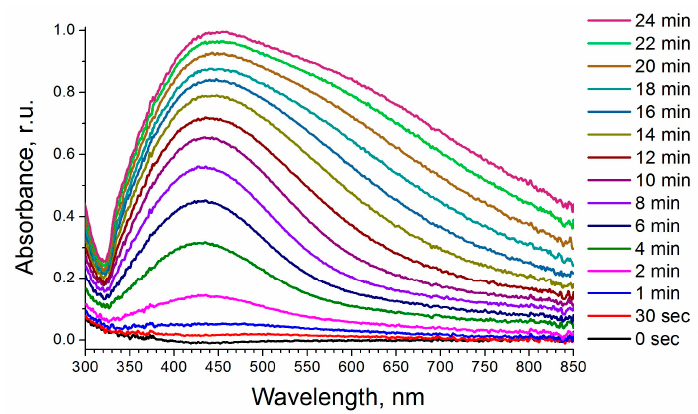
Figure 1. UV-vis spectra of silver(I) citrate complex in 1:1 H 2 O:EG solvent after 312 nm illumination for 2–24 min.